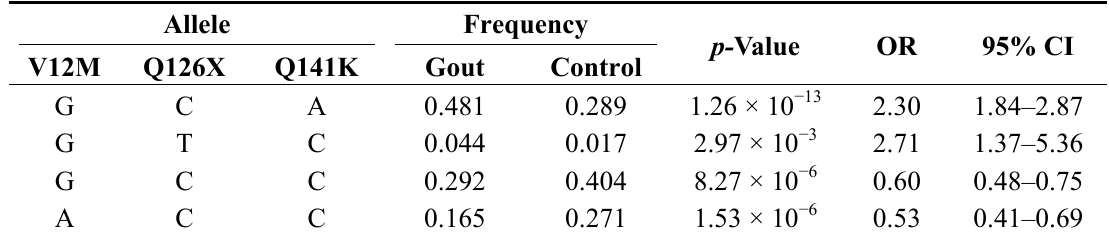
Table 2. Haplotype frequency analysis of V12M, Q126X and Q141K.